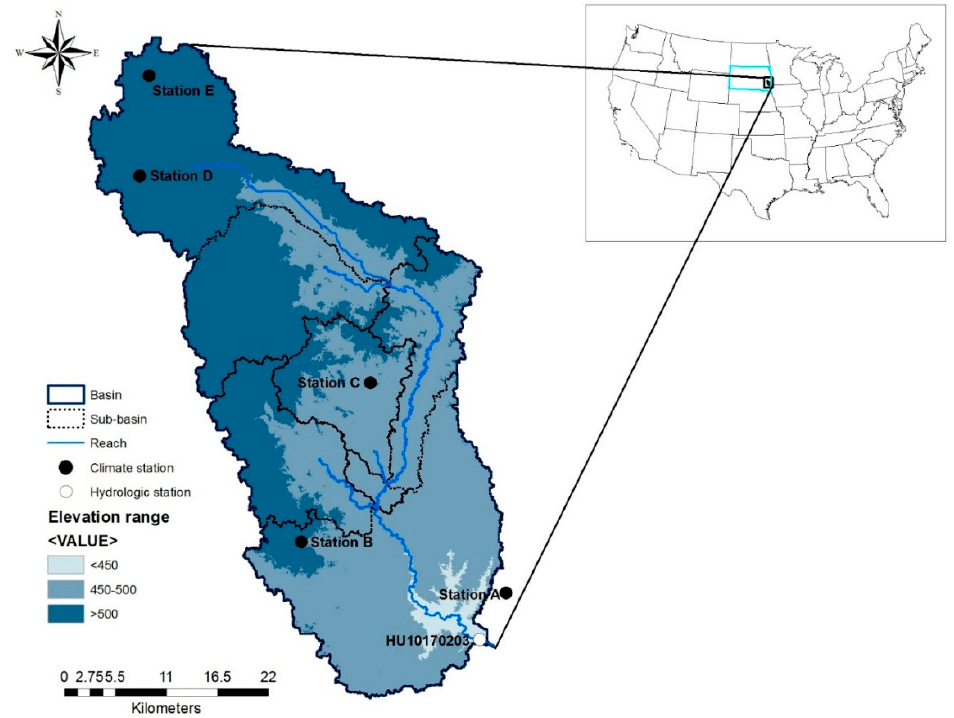
Figure 1. Delineated Skunk Creek basin using digital elevation model within soil and water assessment tool into seven sub basins with locations of climate stations (A–E) and hydrologic stations (HUC1017023).